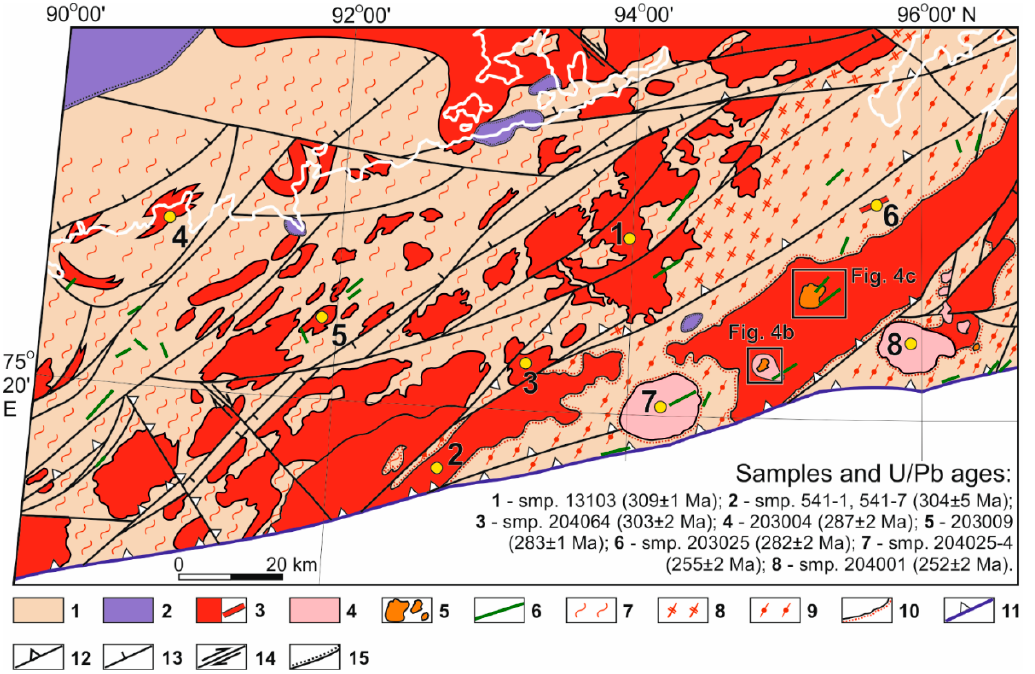
Figure 3. Geology of the central part of the Northern Domain, with locations of some of the studied syn- and postcollisional granitoid intrusions. Modified from state geological map [84]. 1—metasandstones, metasiltstones, metapelites, carbonaceous shales (NP 3 – Є ); 2—Jurassic-Cretaceous sands, clays